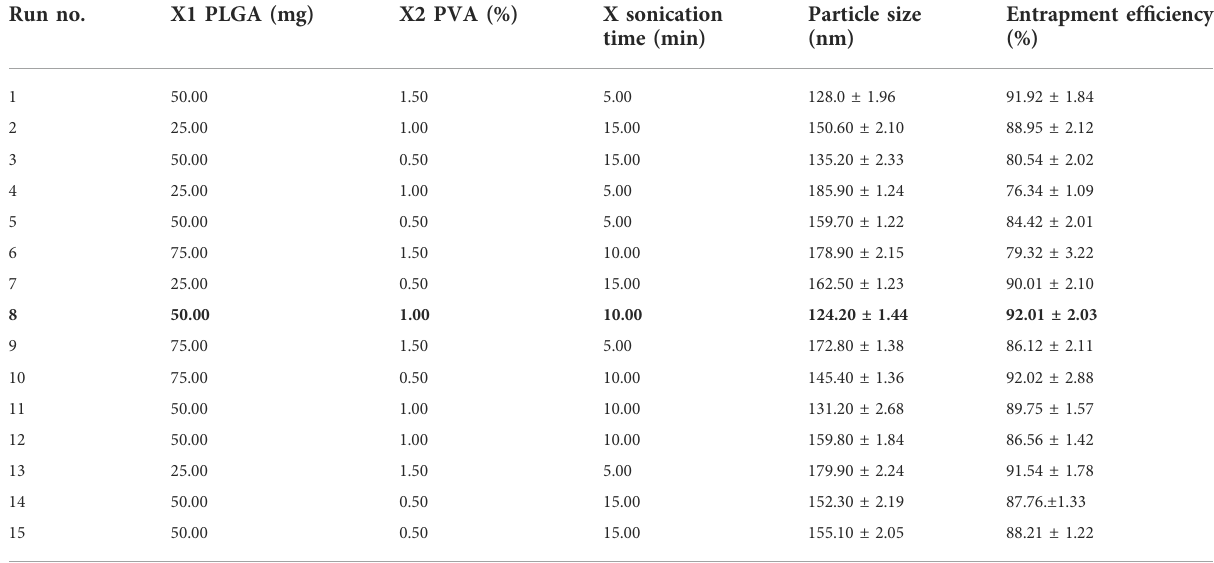
TABLE 2 Effect of various independent variables on dependent parameters for DL formulation prepared through Box − Behnken Design (all values expressed are Mean ± SD where n = 3). Run